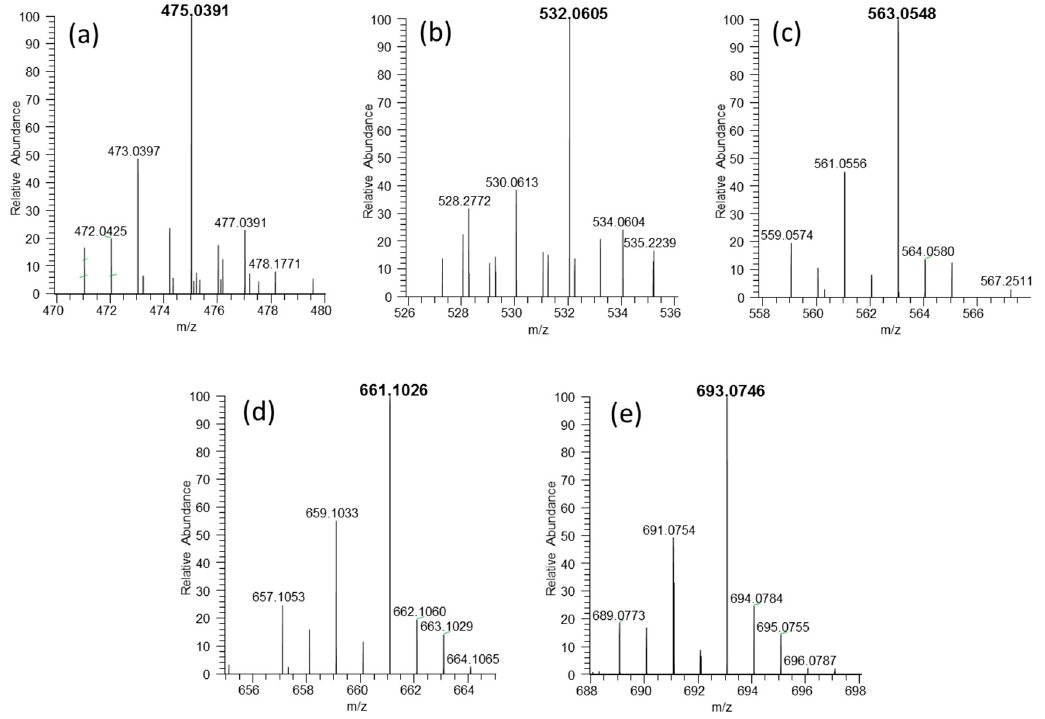
Figure 6. ( a – e ) ESI MS spectra showing isotopic pattern of Se-glutathione species detected in C. utilis water extract.